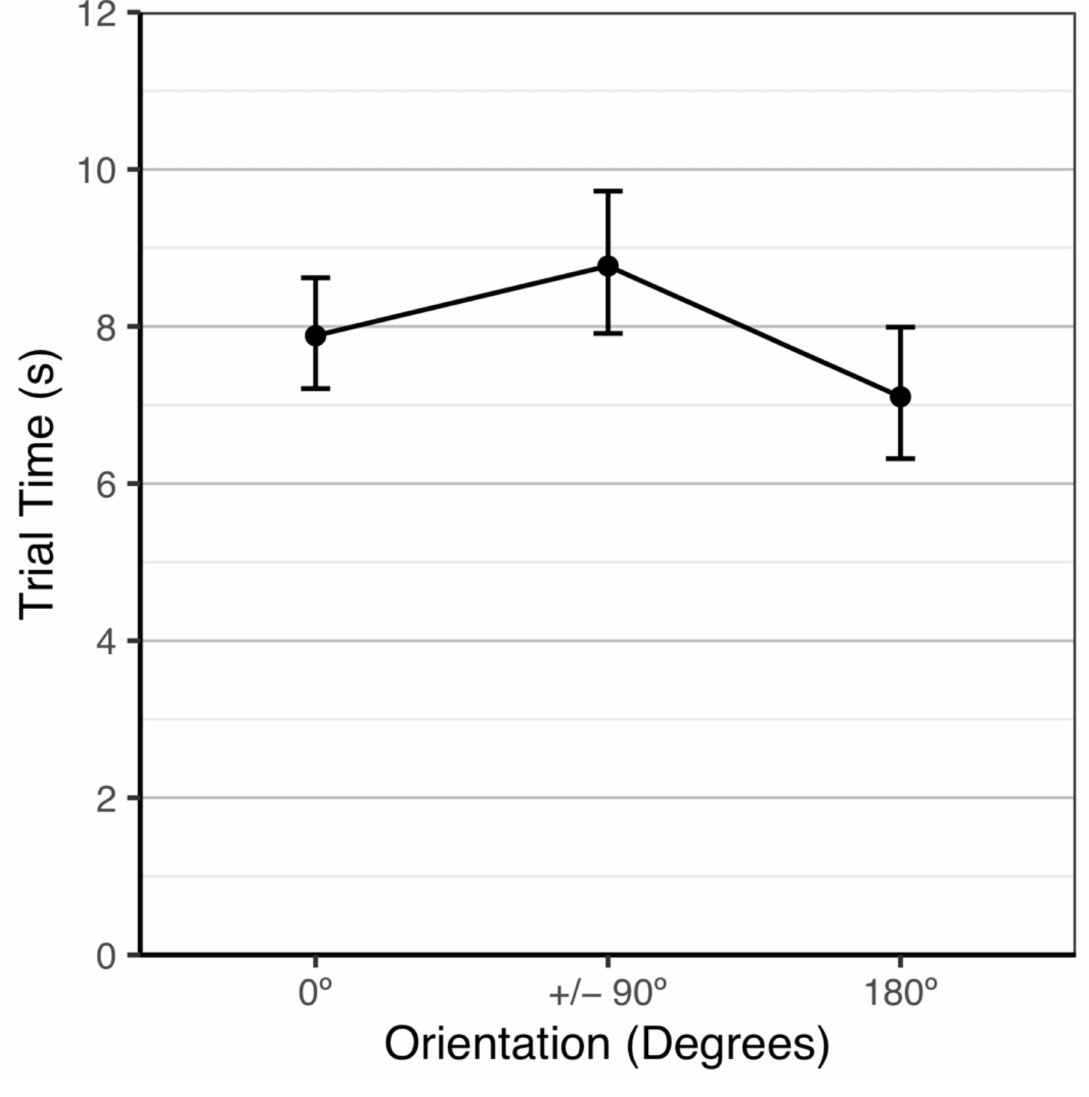
Figure 3. Average testing trial time over stimuli orientations with 95% Tukey-adjusted confidence